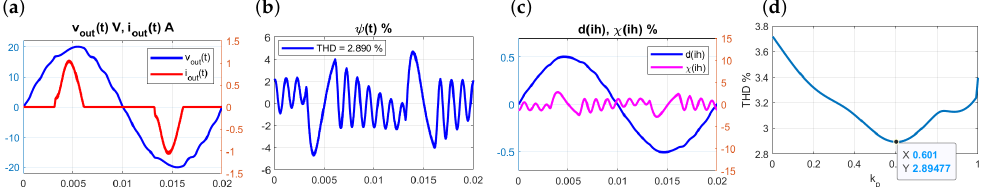
Figure 30. Control with the digital P controller. ( a – c ) steady-state variables, ( d ) THD as a function of k p . Note a small improvement of THD from 3.72% in OL to 2.9% with the P controller.